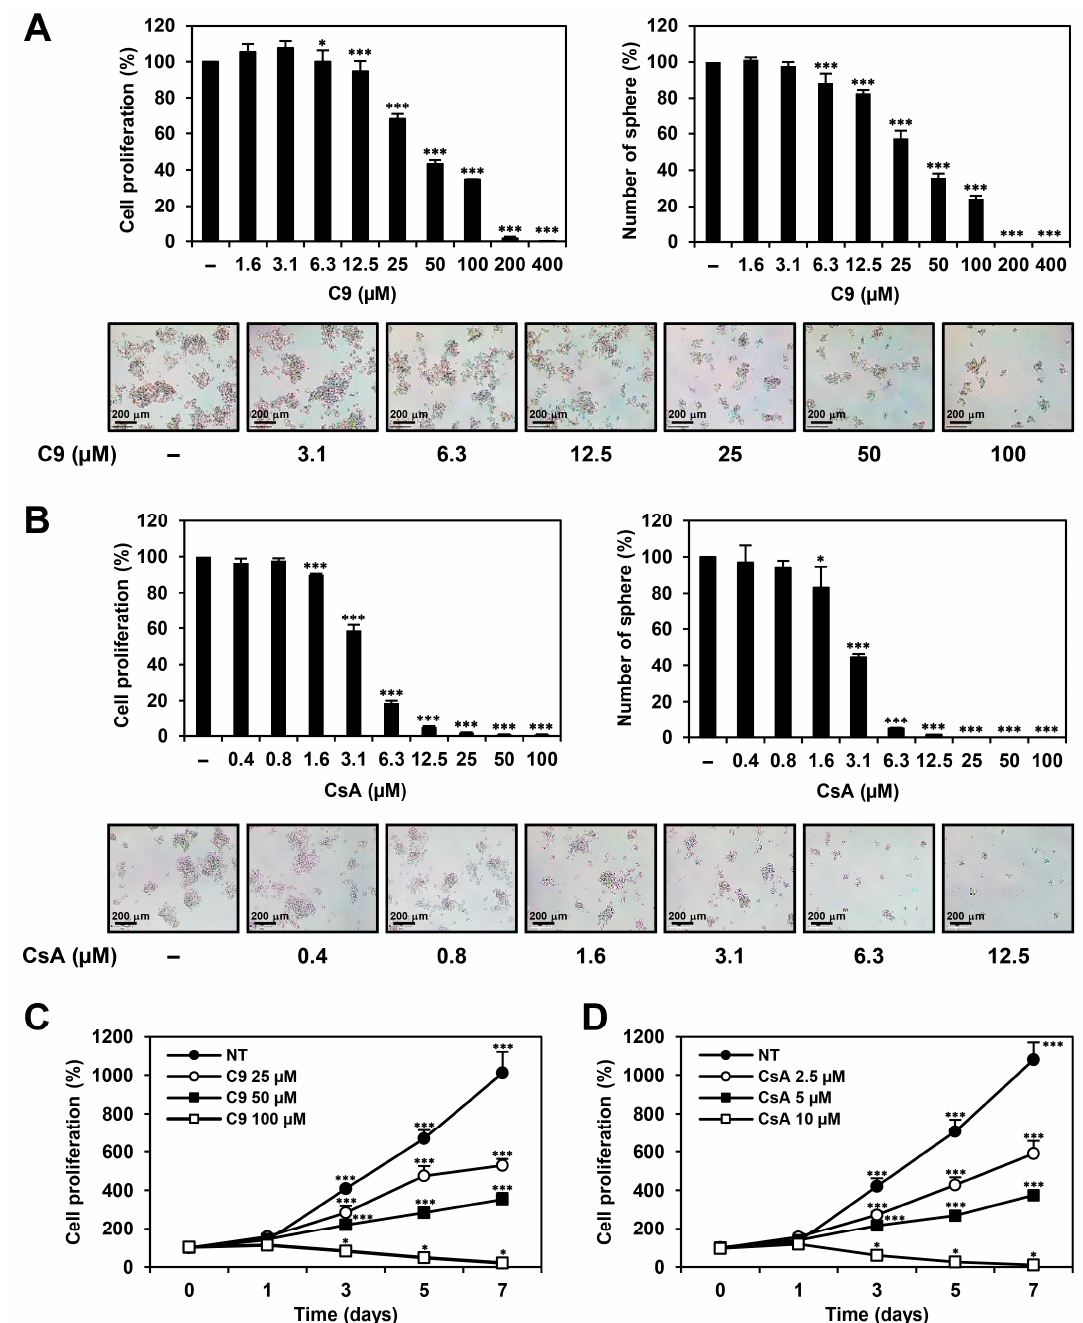
Figure 3. Dose- and time-dependent effects of C9 and CsA on the proliferation of MKN45 GCSCs. MKN45-derived GCSCs were treated with the indicated concentrations of ( A , C ) C9 and ( B , D ) CsA for seven days. Cell proliferation was measured using the CellTiter-Glo ® luminescent assay system. Formed tumorspheres were counted under an optical microscope. * p < 0.05, *** p < 0.001 vs. the control.